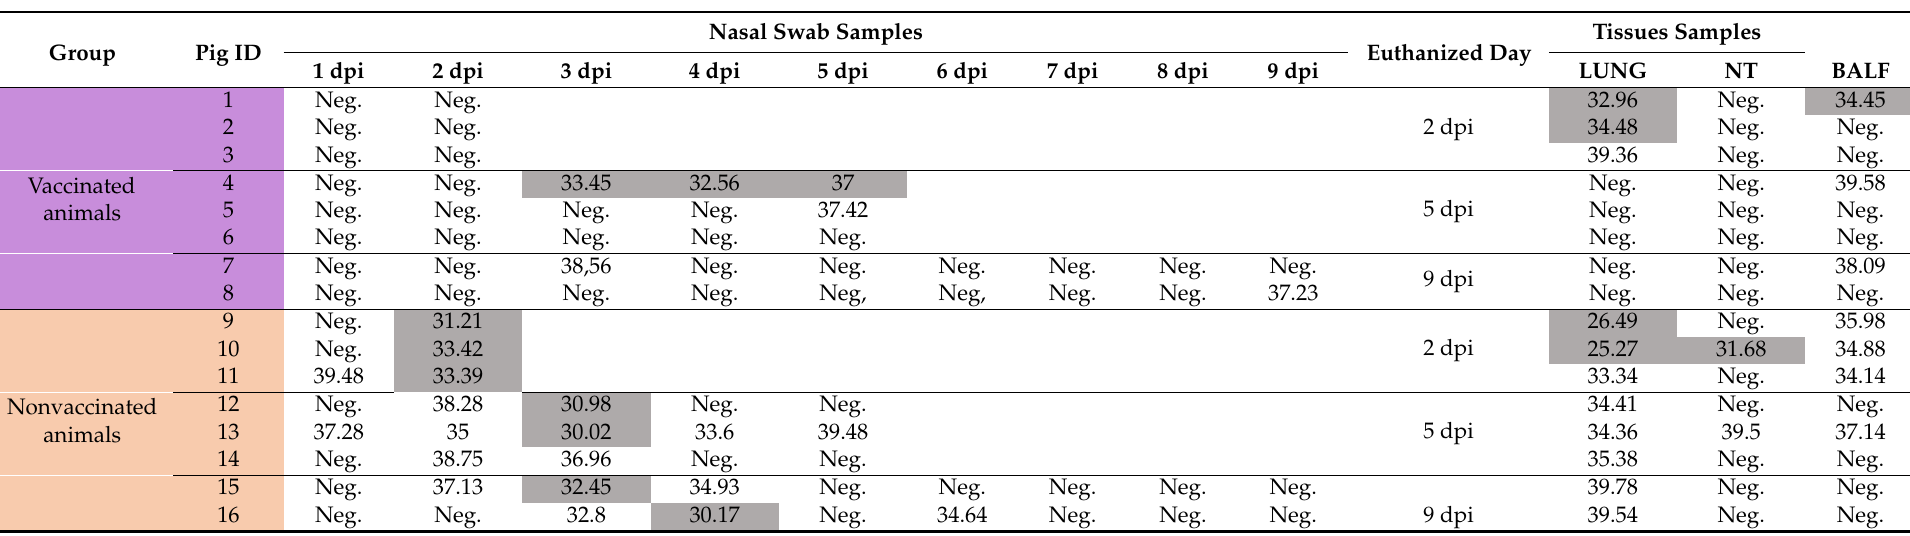
Table 2. SIV detection in nasal swab samples collected at different time points and from BALF, lung, and nasal turbinate. RT-qPCR Ct values results are shown in the table. Neg.: negative. Highlighted cells represent sequenced samples. Violet and orange cells indicate the group of each animal, vaccinated and nonvaccinated,